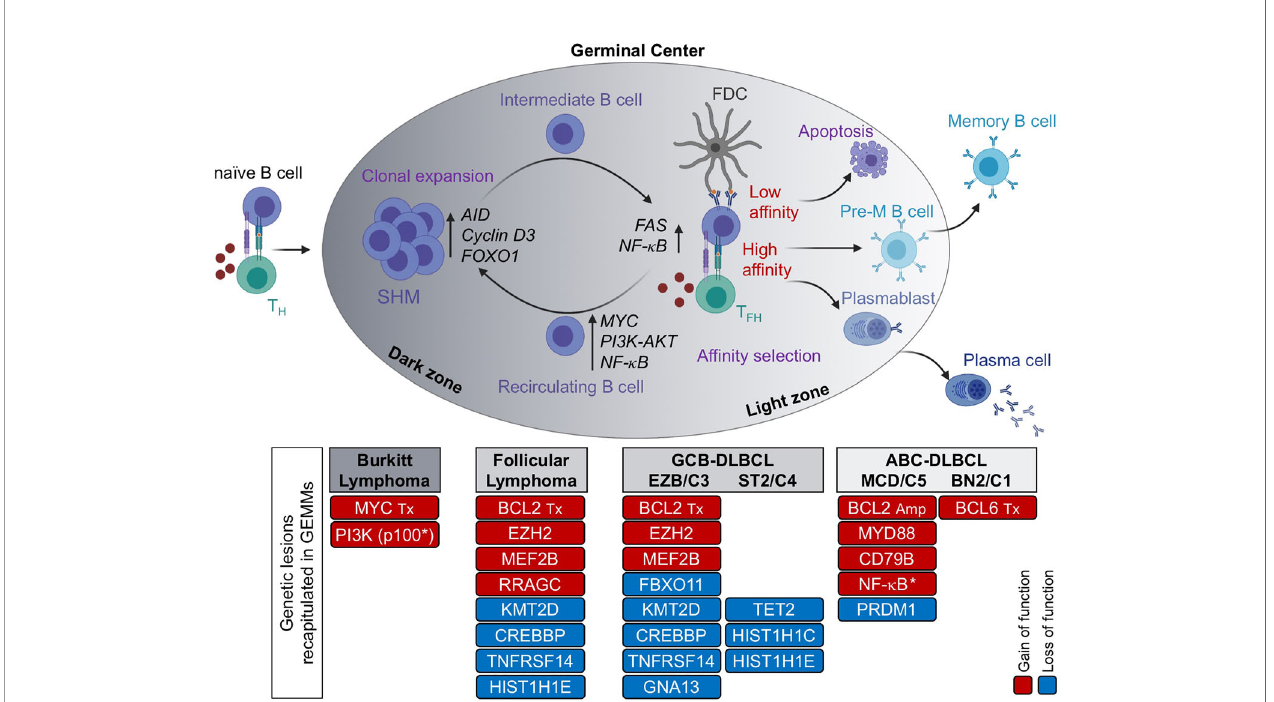
FIGURE 1 | The GC reaction as the normal counterpart of most B cell lymphomas. Formation of a GC begins when a naïve B cell encounters an antigen in the presence of co-stimulatory molecules, provided by a T helper cell. The GC is functionally and histologically divided into two main compartments, the dark zone (DZ) and the light zone (LZ). Within the DZ, cells undergo somatic hypermutation (SHM) of their immunoglobulin genes and rapid proliferation, whereas in the LZ, B cells are intermingled with follicular dendritic cells (FDCs) and T follicular helper (T FH ) cells, which provide positive selection signals to B cells with high af fi nity to the antigen. The LZ is also the site of CSR. By repeatedly cycling between the DZ and the LZ, B cells undergo several rounds of proliferation, SHM and af fi nity maturation before being positively selected. In contrast, B cells with low af fi nity for the antigen are eliminated by apoptosis. High af fi nity B cells that exit the GC differentiate into long-lived memory B cells or antibody-secreting plasma cells. Based on molecular pro fi ling, Burkitt lymphoma is postulated to derive from DZ B cells, FL and GCB-DLBCL from LZ B cells, and ABC-DLBCL from B cells poised to undergo terminal differentiation (plasmablasts) or, in a subset of cases, pre-memory B cells. Genetic lesions that have been successfully modelled in the mouse and recapitulate key features of the human disease are indicated. Red, gain of function events; blue, loss of function events. M, mutation; Tx, translocation; Amp, copy number gain/ampli fi cation; *, pathway activation by use of a constitutively active